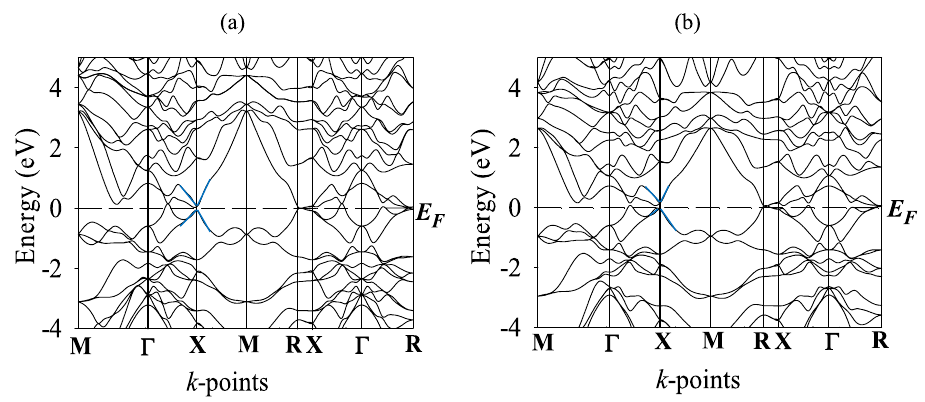
Figure 2. Electronic band structures of ( a ) TaP and ( b ) TaAs along several high symmetry directions in the Brillouin zone at P = 0 GP. Some of the quasi-linear dispersive regions are marked by blue